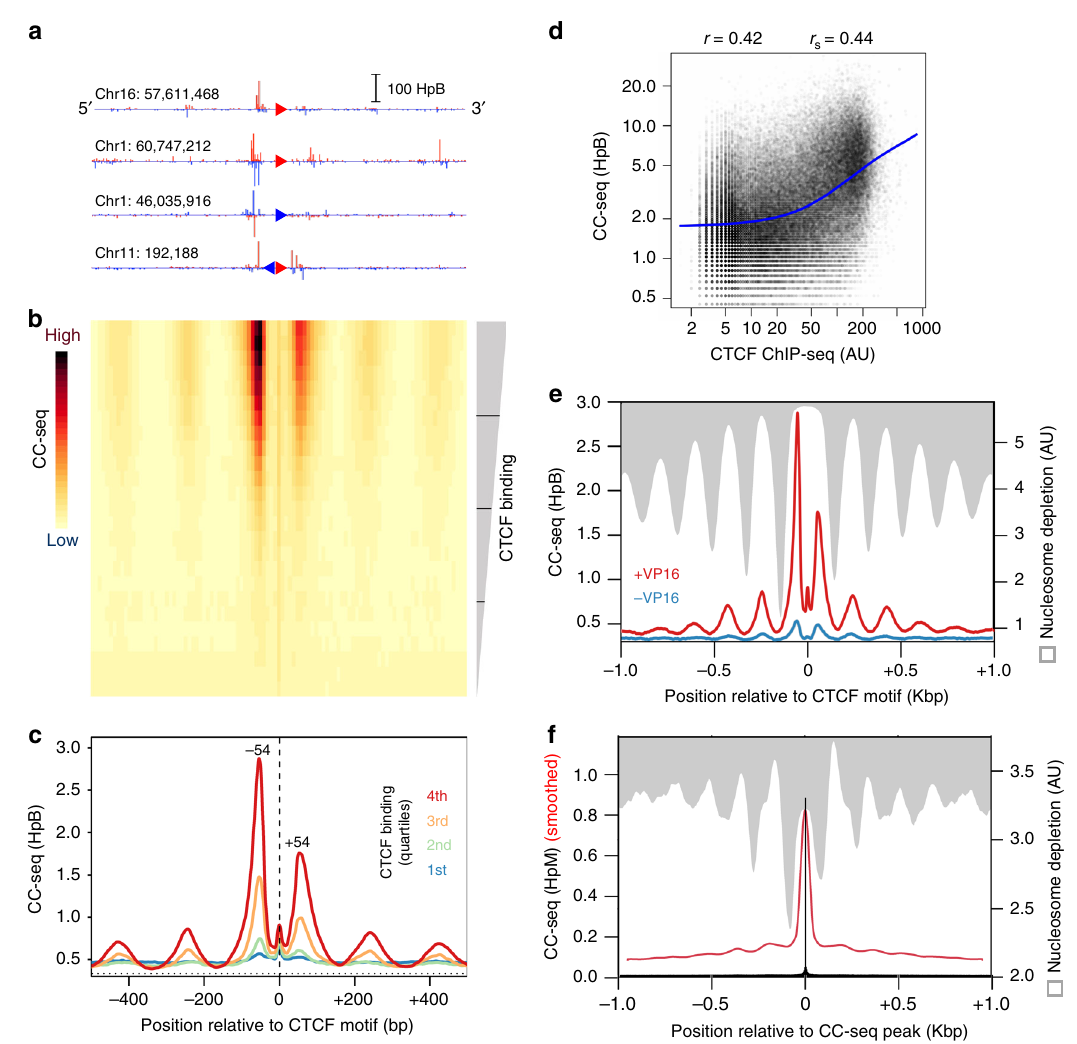
Fig. 4 CTCF-proximal TOP2 activity is tightly con fi ned within nucleosome-depleted regions. a – c Aggregation of TOP2 CCs in a 1 Kbp window centred on orientated CTCF motifs in human RPE-1 cells. Four example CTCF loci are shown orientated in the 5 ′ -3 ′ direction. Red and blue triangles indicate Watson and Crick CTCF motifs, respectively ( a ). A heatmap of all CTCF-motifs in the human genome, with 25 aggregated rows strati fi ed by the strength of colocalising CTCF ChIP-seq peaks in RPE-1 cells. The colour scale indicates average TOP2 CC density in each 10 bp bin ( b ). Motifs are also strati fi ed into quartiles of CTCF-binding, and the average TOP2 CC distribution in each quartile plotted. Horizontal line is the genome mean. Vertical line is the TSS ( c ). d Quantitative relationship between CC-seq (±100 bp) and CTCF ChIP-seq signal centred on CTCF motifs. Blue line = lowess curve. Pearson r and Spearman r s values were calculated between CC-seq and log-transformed CTCF ChIP-seq. e Aggregated TOP2 CC distribution (red line) in the highest quartile of CTCF-binding compared with the average MNase-seq signal 71 (grey). f Aggregated TOP2 CC distribution (black and red lines: single-nucleotide resolution and smoothed, respectively) and the average MNase-seq signal (grey) surrounding strong TOP2 CC sites. MNase-seq data in ( e – f ) is inverted to emphasise spatial relationship between CC-seq and nucleosome depletion (white). HpM, HpB Hits per million (or billion) mapped reads per base